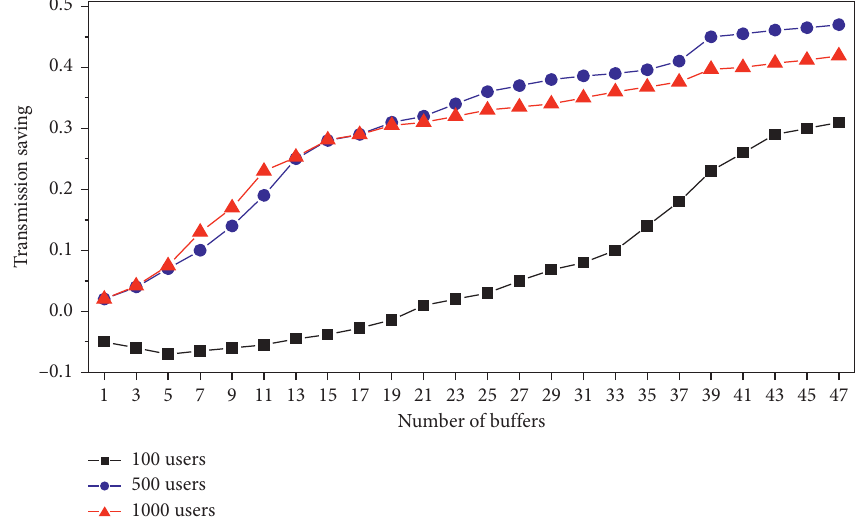
Figure 8: The relationship between the transport savings and the number of buffers with different number of